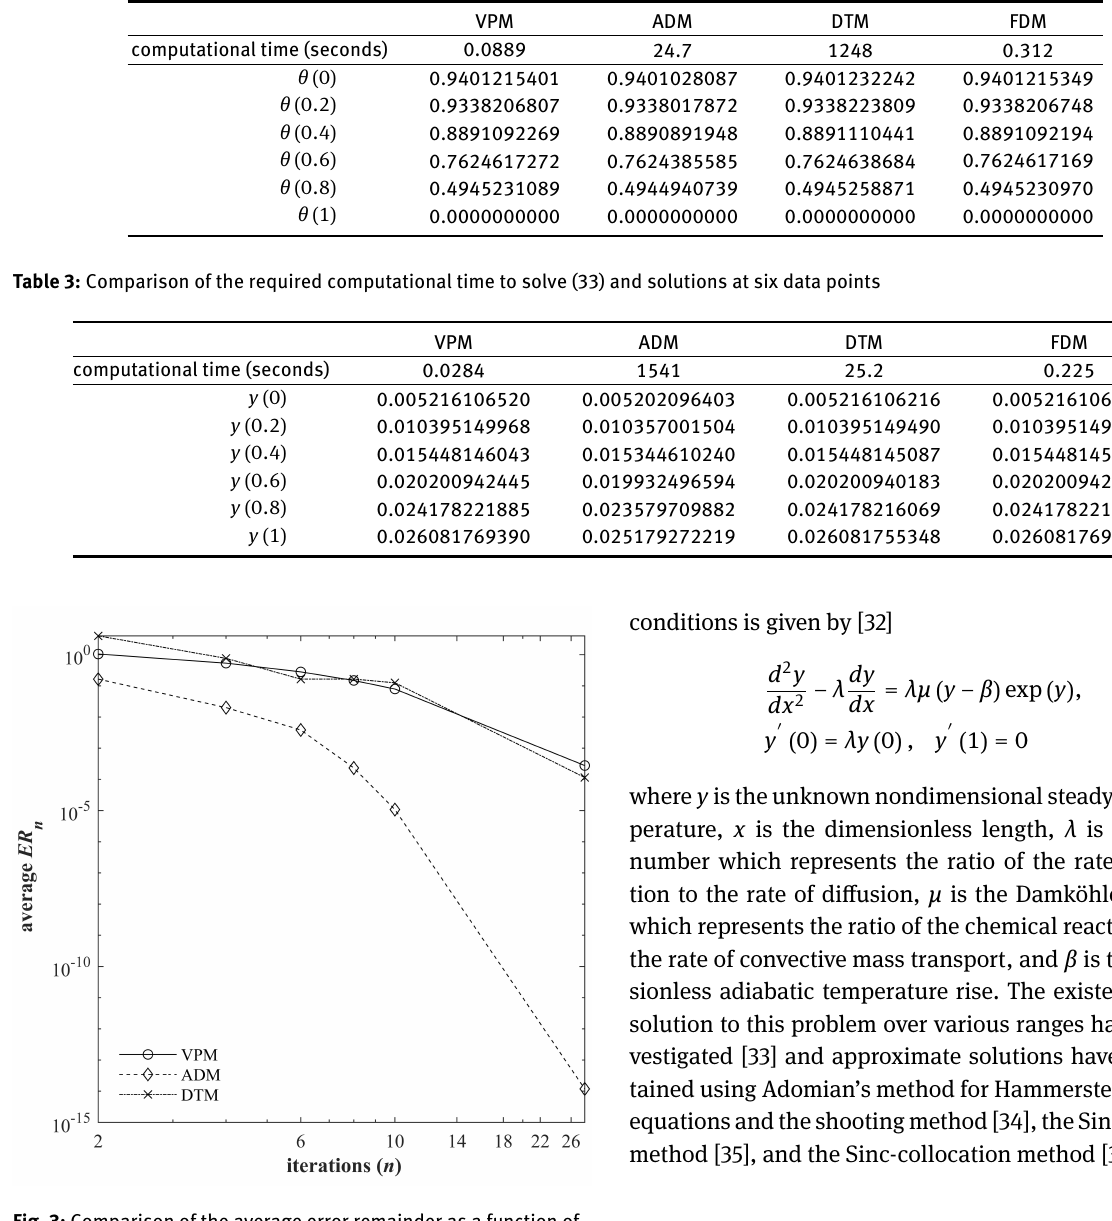
Table 2: Comparison of the required computational time to solve (26) and solutions at six data points